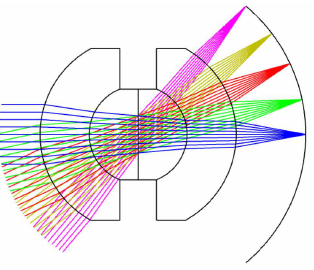
Figure 5. Configuration of the front concentric imaging group.